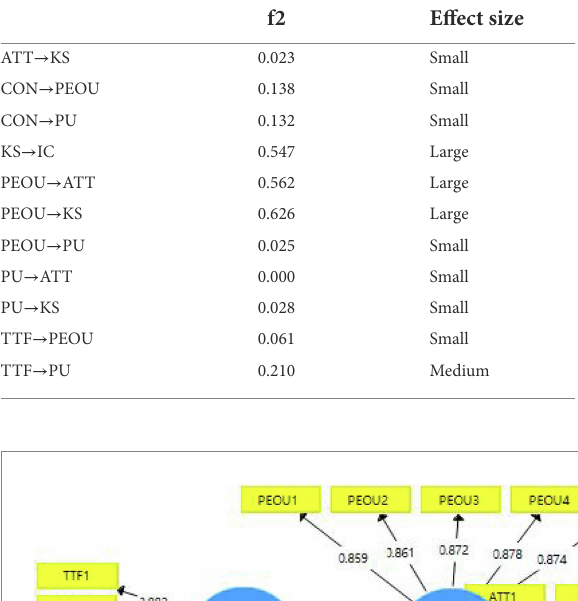
TABLE 8 Effect size (f 2 ).